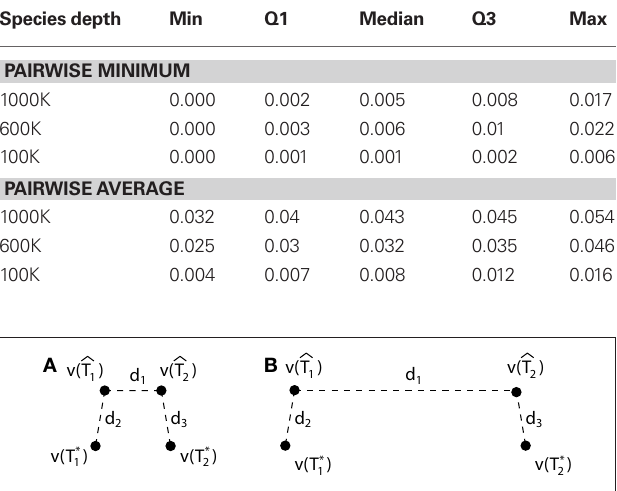
Figure 1 | a diagram showing two cases of the differences of means method. T